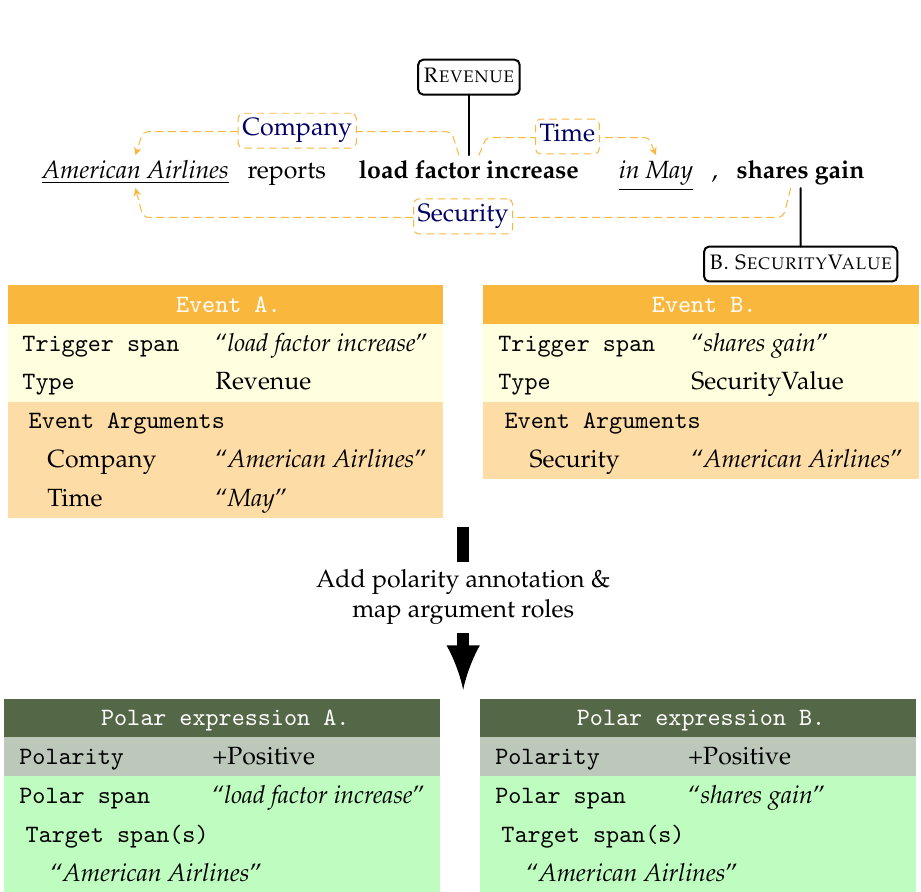
Figure 3. Example of event-induced polar expressions obtained by adding implicit polarity annota- tion and mapping argument roles to